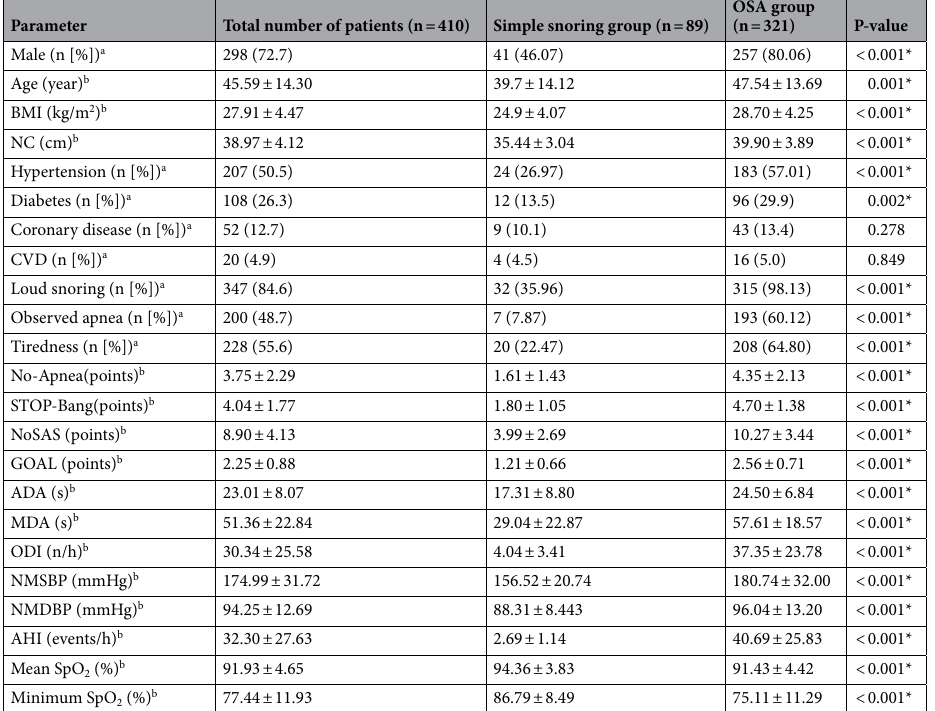
Table 1. Demographic and polysomnographic characteristics (n = 410). Comparisons between groups were tested by χ test and t-test. P < 0.05 was defined as statistically significant. a Frequency (%) and χ test; b Mean and variance, and t-test. *P < 0.05. BMI body mass index, NC neck circumference, CVD cerebrovascular disease, ADA average duration of apnea, MDA maximum duration of apnea, ODI oxygen desaturation index, NMSBP nocturnal maximum systolic blood pressure, NMDBP nocturnal maximum diastolic blood pressure, AHI apnea hypopnea index, Mean SpO 2 mean oxygen saturation, Minimum SpO 2 minimum oxygen saturation. Numeric and categorical variables were reported as mean ± standard deviation and N (%), respectively.